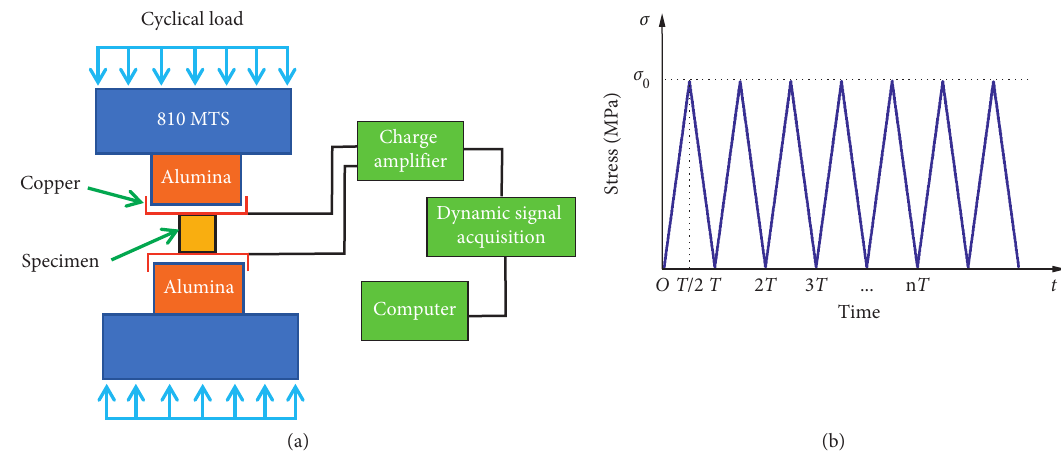
Figure 3: Illustration of (a) the experimental setup and (b) loading curve, where T indicates a loading period.